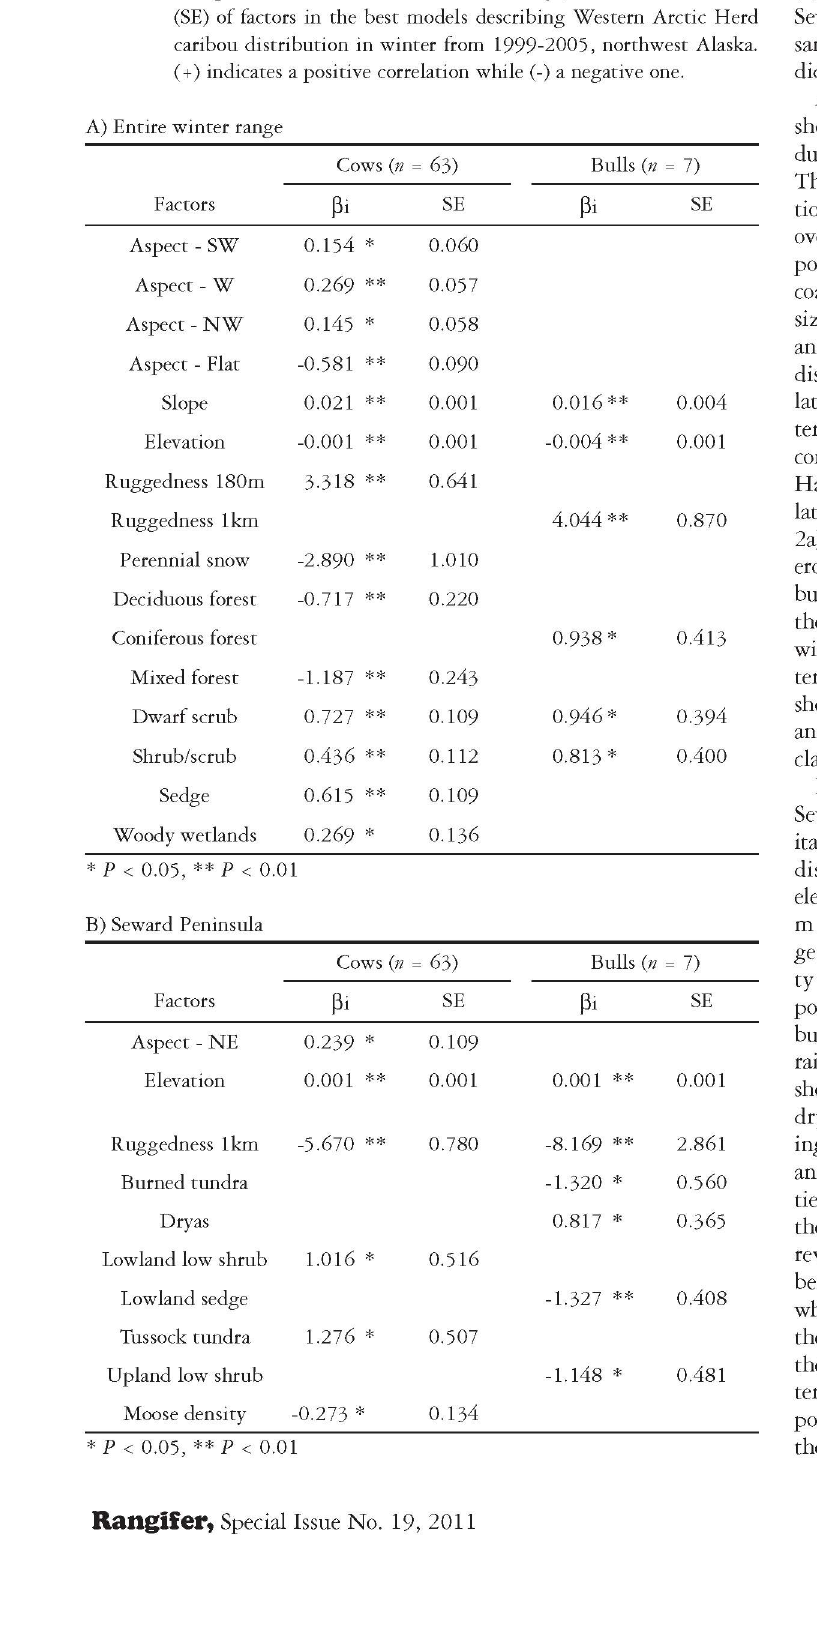
Table 2. Comparison of coefficients of selection (Pi) and standard errors (SE) of factors in the best models describing Western Arctic Herd caribou distribution in winter from 1999-2005, northwest Alaska. (+) indicates a positive correlation while (-) a negative